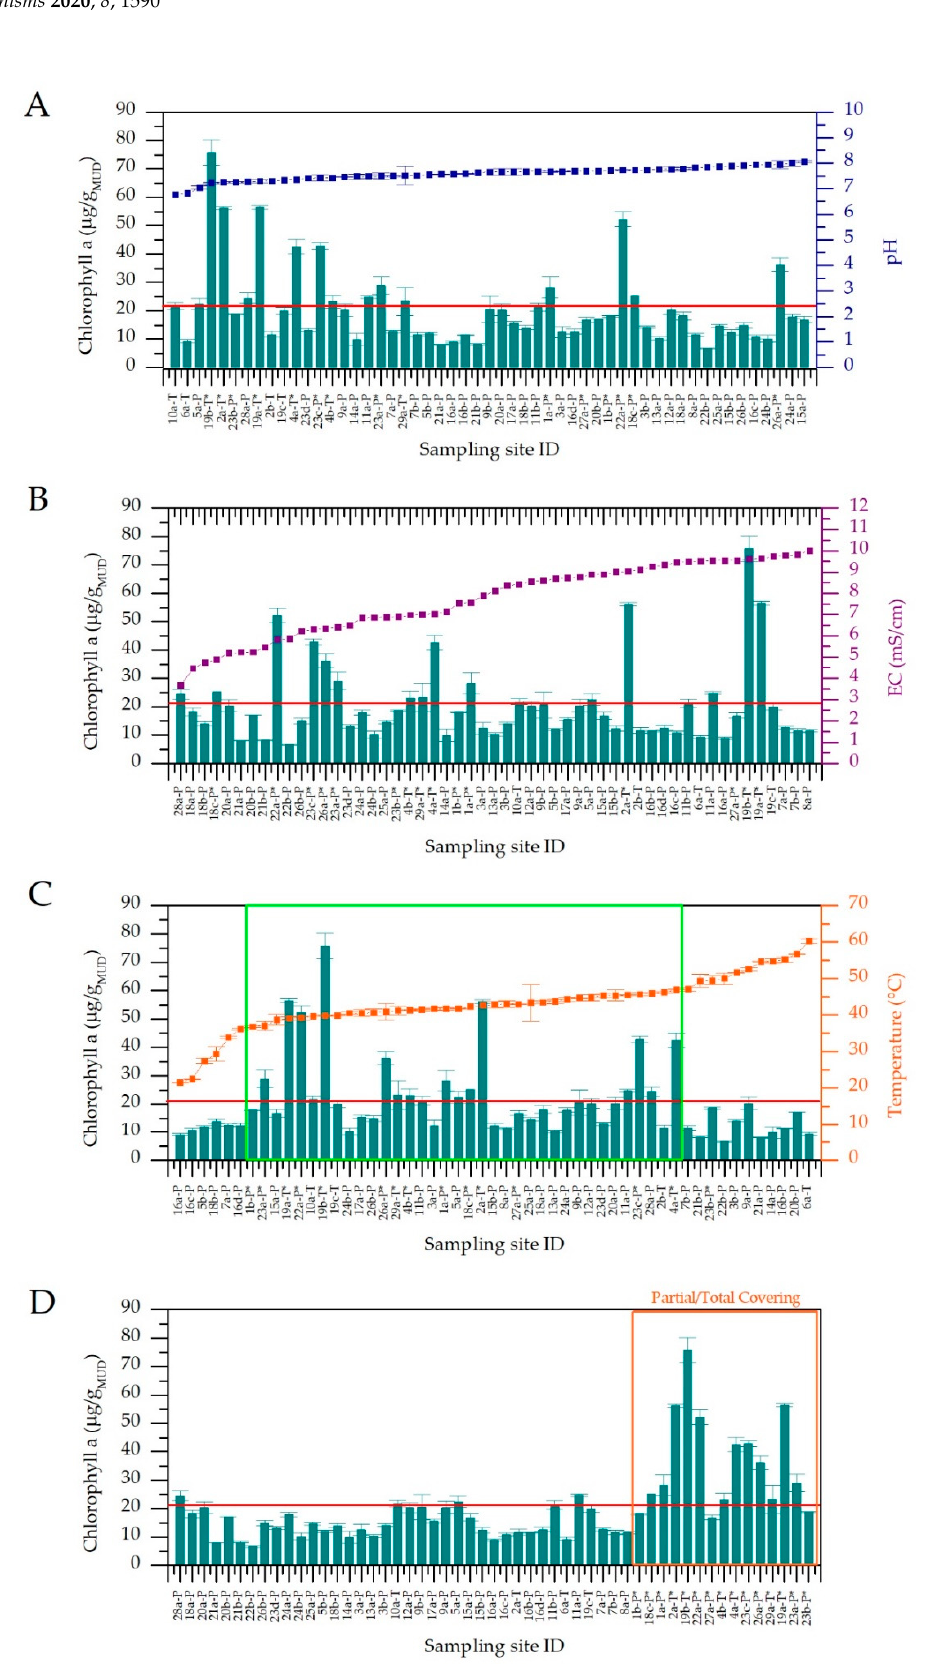
Figure 3. Chlorophyll a content of mature muds of the di ff erent spas as function of increasing values of pH ( A ), electric conductivity ( B ), temperature ( C , D ) sorted by the absence or presence of protective roofs ( D ). Red lines indicate the average Chl a content of mature muds at the end of maturation process. In figure C, the green box represents the central temperature range (37–47 ◦ C). (Sample collected from maturation systems provided by protective roofs are indicated with *).